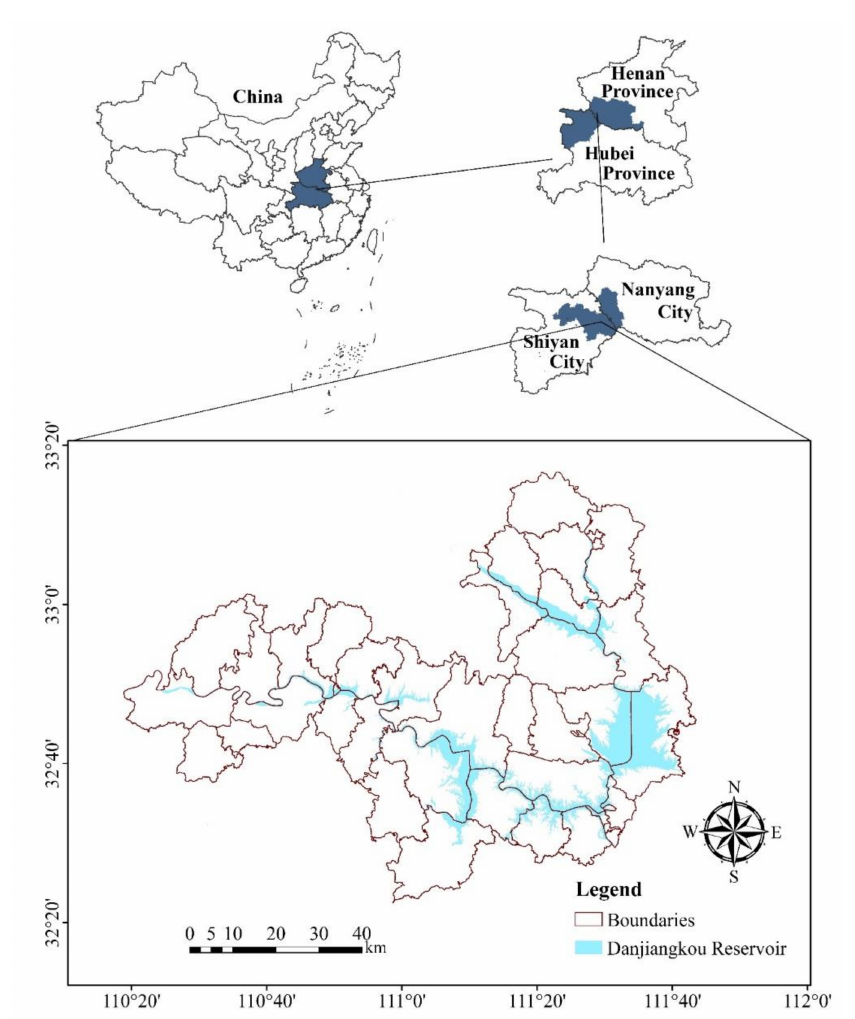
Figure 1. Location map of core water source area of Middle Route of South-to-North Water Diversion Project,